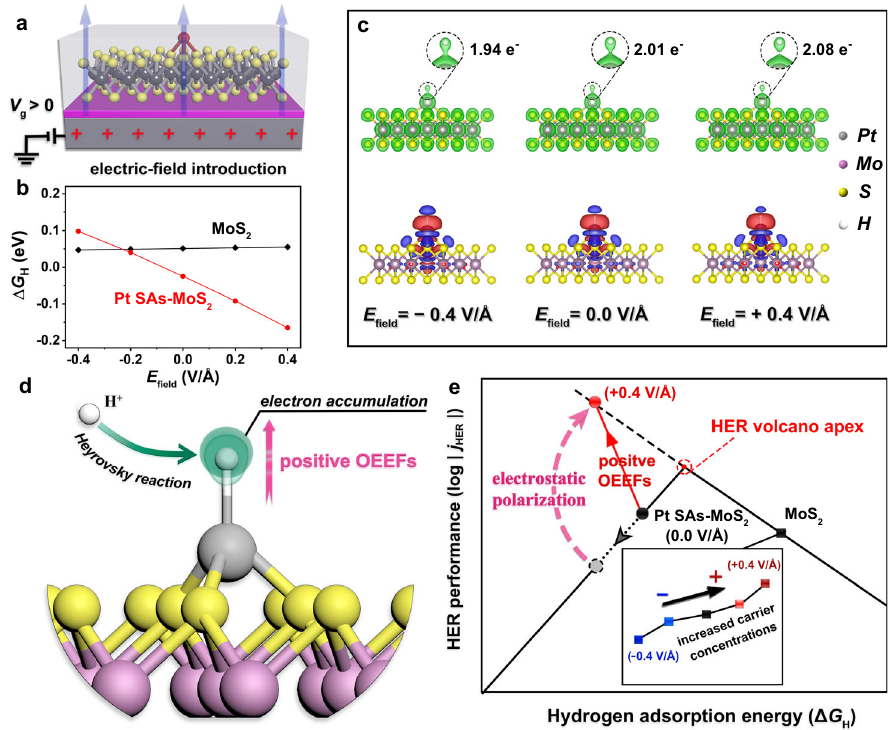
Fig. 3 “ Onsite electrostatic polarization ” in the Pt SAs-MoS 2 catalyzed HER. a Schematic diagram of the electric- fi eld introduction into Pt SAs-MoS 2 . b Hydrogen adsorption energy ( Δ G H ) in the models of 2H-MoS 2 (black) and ( M-top )-Pt SAs-MoS 2 (red), with E fi eld from − 0.4 V/Å to + 0.4V/Å. c Charge analysis of ( M-top )-Pt SAs-MoS 2 under OEEF regulation, where *H is adsorbed on Pt atom. Top: charge densities with interface values of 0.15e − /Bohr 3 . The zoomed-in area shows the charge distribution at the fi rst adsorbed *H site. Bottom: deformation charge densities with interface values of 0.001e − /Bohr 3 . Red and blue areas denote electron accumulation and depletion, respectively. E fi eld from left to right is − 0.4V/Å, 0, and + 0.4V/Å. d Schematic diagram of the + in electrolyte tends to move towards the fi rst “ onsite electrostatic polarization ” mechanism on Pt SAs-MoS 2 for HER. During the Heyrovsky reaction, H adsorbed *H site, where electron accumulation was triggered by positive OEEFs. e The positive-OEEF-induced breakthrough at HER volcano apex ( j HER - Δ G H ) in Pt SAs-MoS 2 . Inset: HER performance of pristine MoS 2 associated with the OEEF-regulated carrier concentrations (consistent with the j HER - G s correlation observed in Fig. 2g), rather than the slight change in Δ G H (black solid line in b